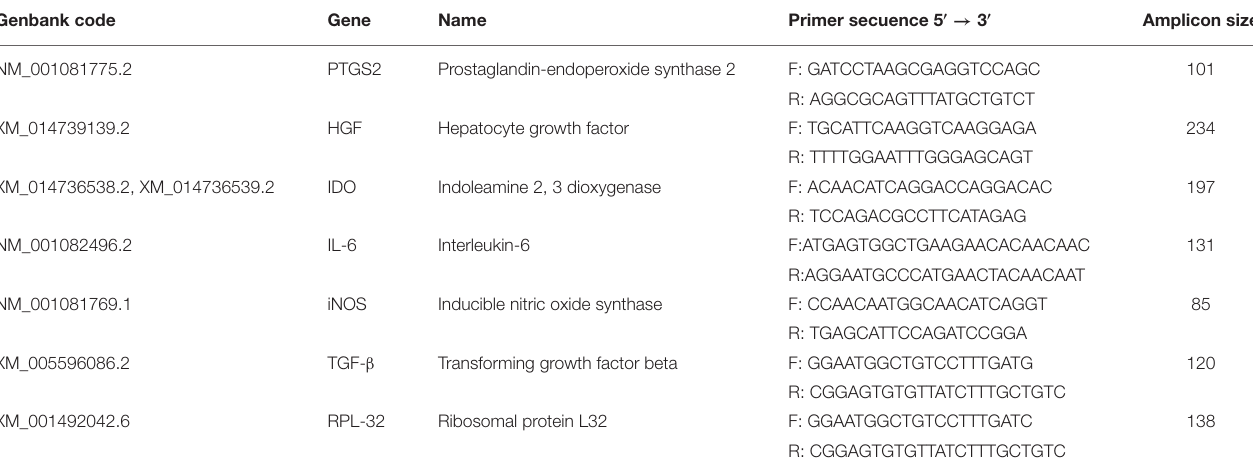
TABLE 2 | Primer sequences used to evaluate the effect of pre-conditioning on the expression of immunomodulatory molecules by MSCs. Genbank